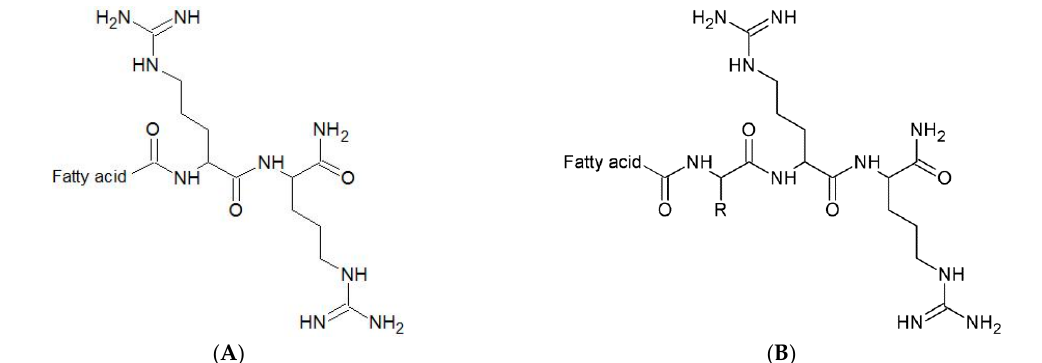
Figure 1. The general structure of the lipopeptides used: ( A )—reference lipopeptides and lipopeptides with branched fatty acid chain; ( B )—analogs with additional N -terminal amino acid (R). R–Side Chain of Substituted Residue.